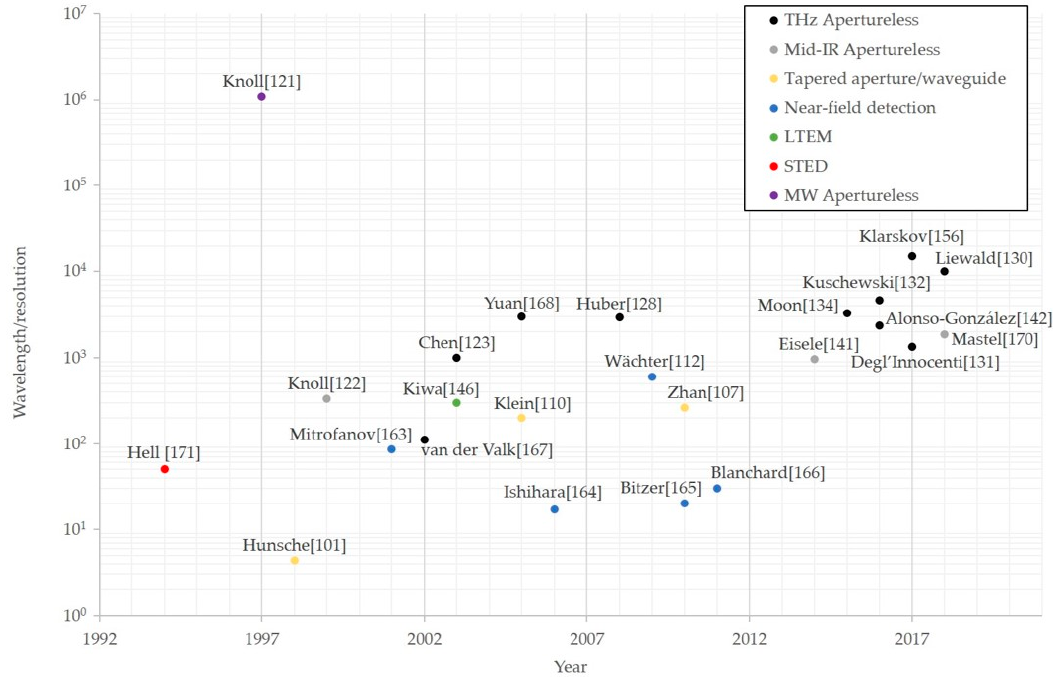
Figure 13. The development of sub-wavelength imaging methods over time.